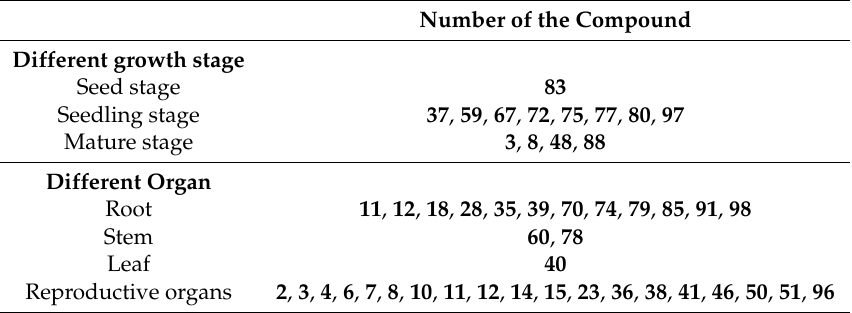
Figure 2 . Venn diagrams of identified metabolites in S. baicalensis . ( A ) was the distribution of unique metabolites and common metabolites in S. baicalensis at seed stage, seedling stage and mature plant stage. ( B ) was the distributions of unique metabolites and common metabolites in root, leaf, stem and reproductive organs of S. baicalensis . Table 2. The unique compounds identified at different growth stages and in different organs .